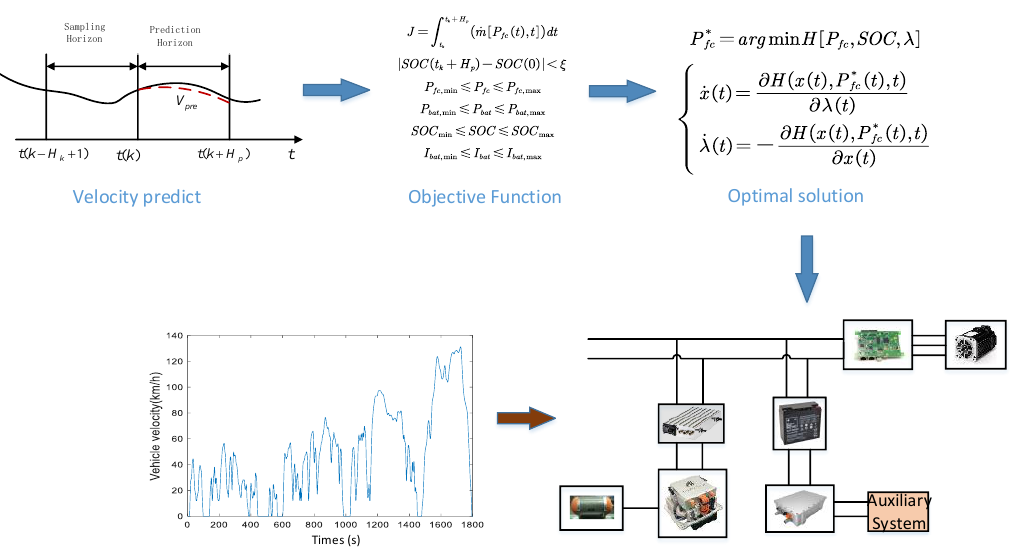
Figure 8. Structure of MPC-based energy management strategy.